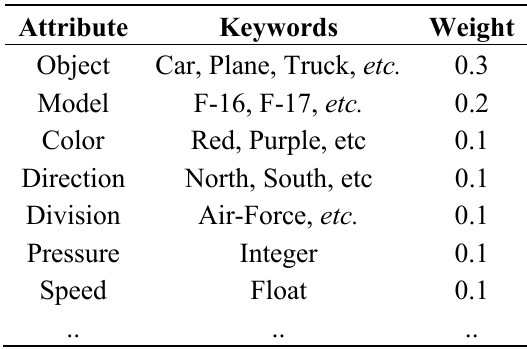
Table 2. Example of Weight Settings